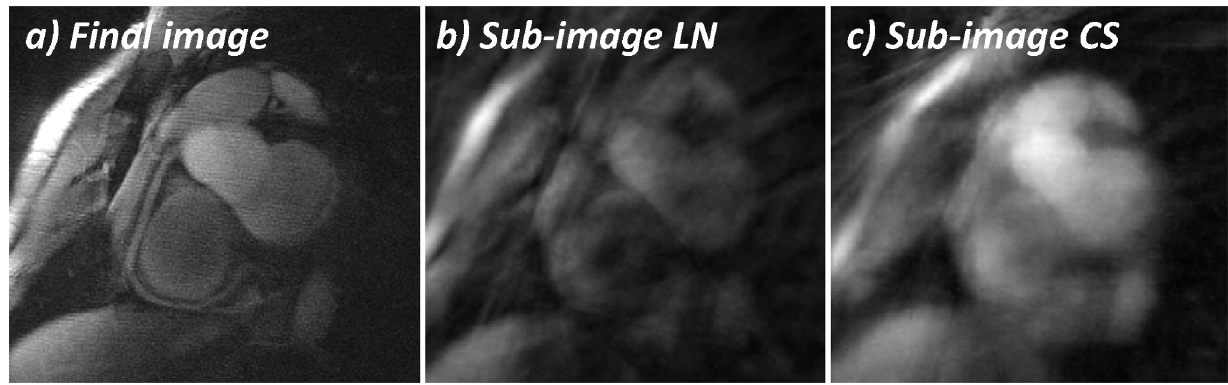
Figure 2. Reconstruction of in vivo sub-images. a) Representative targeted RCA from a conventional NAV acquisition. b) Sub-image obtained in the same subject from one interleave (15 radial spokes out of a total of 360) reconstructed with the linear approach (gridding followed by FFT). c) Sub-image obtained from the same interleave as in (b), however, reconstructed with the compressed sensing method based on Total-Variation.